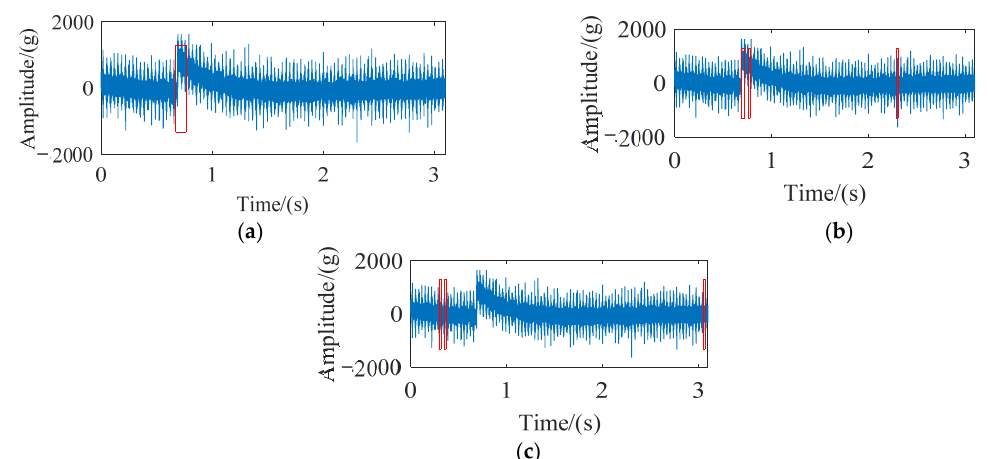
Figure 17. Rolling and vibrating test rig.